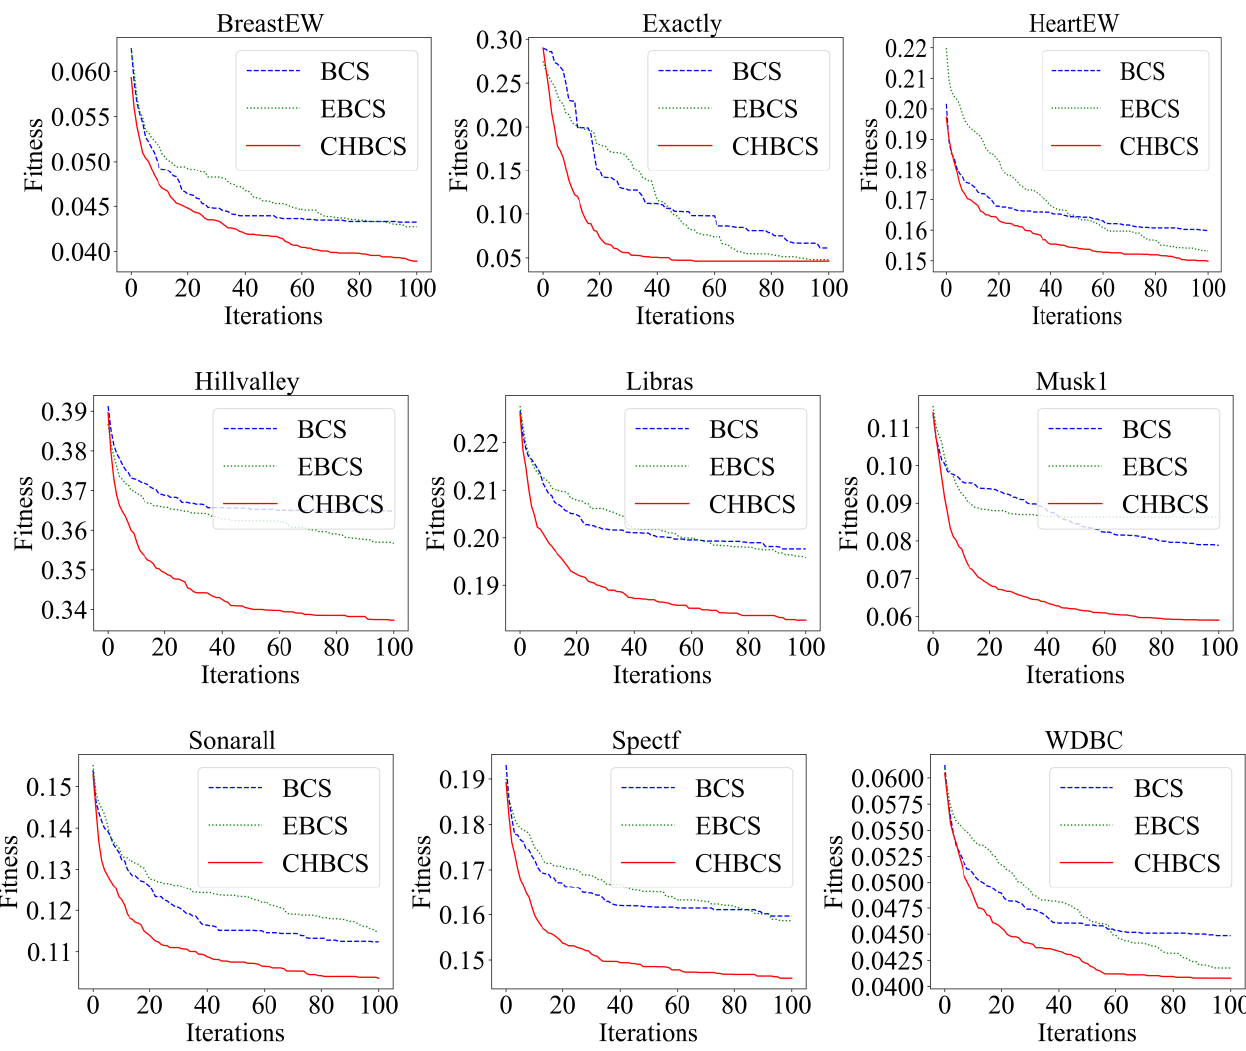
Figure 8. Iterative fitness curves of the three algorithms.